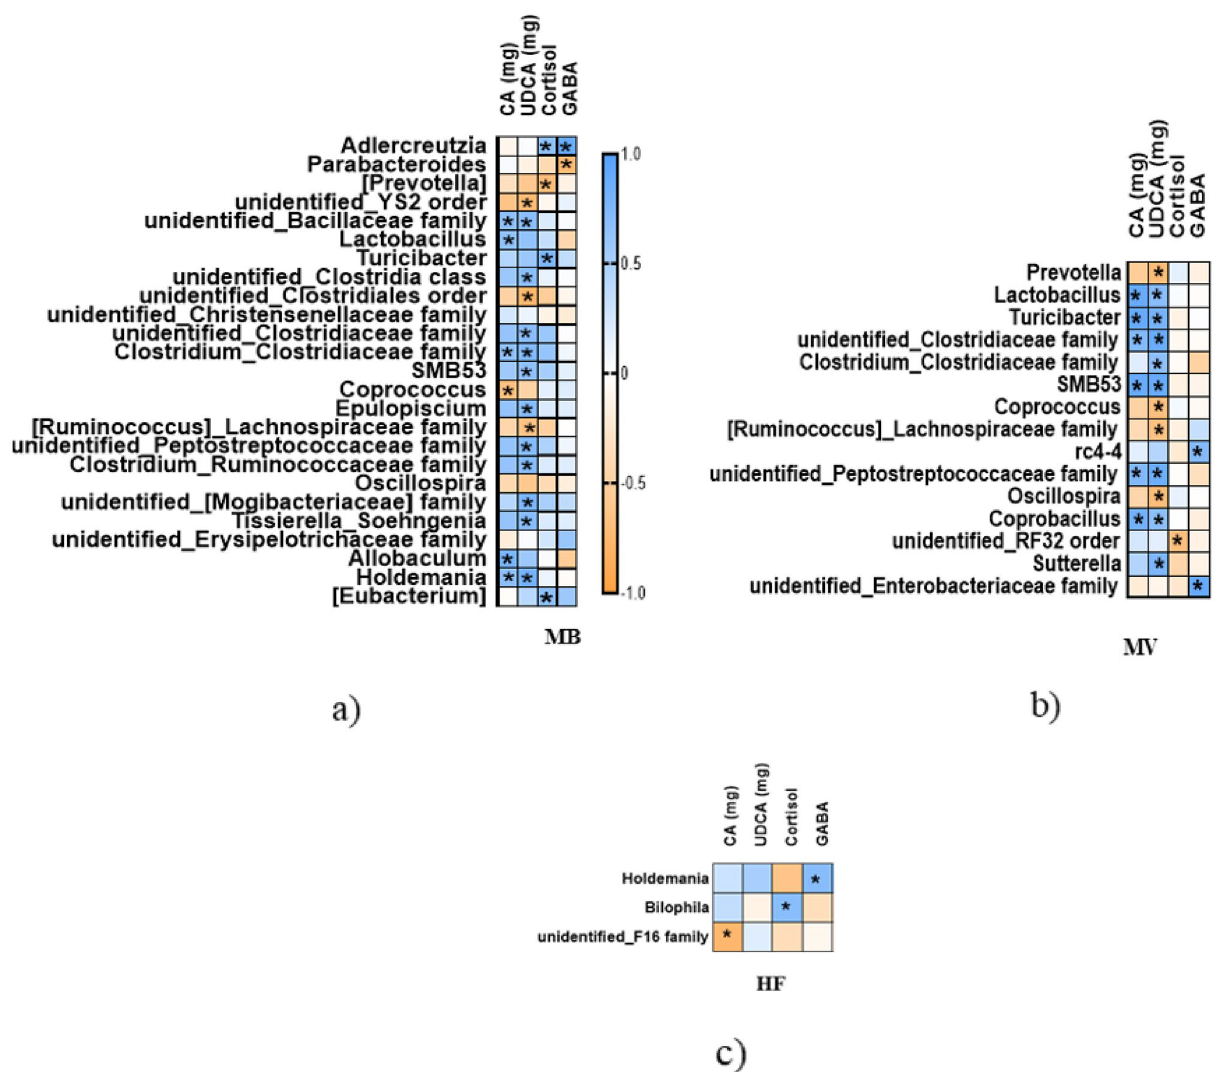
Figure 3. Spearman correlation between caecal bacterial genera and biomarkers. ApoE-/- rats fed a high-fat diet as it is ( c , HF) or supplemented with 1% monobutyrin ( a , MB) or monovalerin ( b , MV). Colour indicator shows positive/negative correlation in blue/orange. Only significant correlations are shown in these figures, which were part of a correlation matrix. Significant values: *, p <